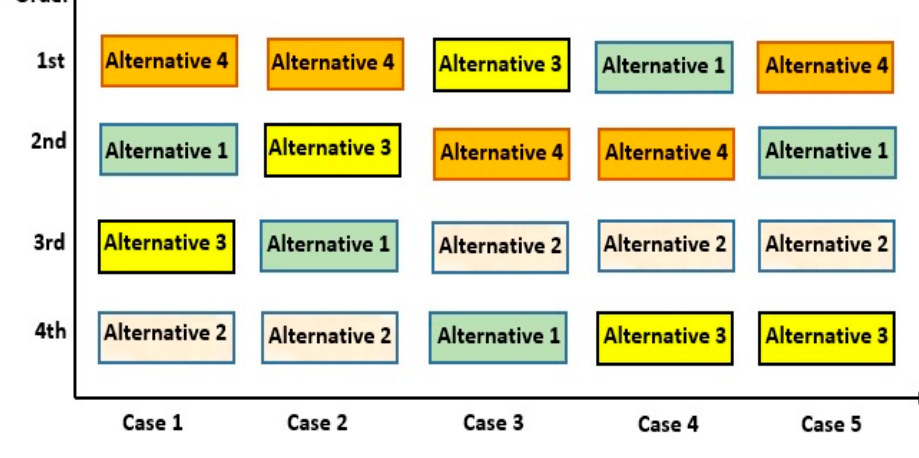
Figure 12. Results of the sensitivity analysis.